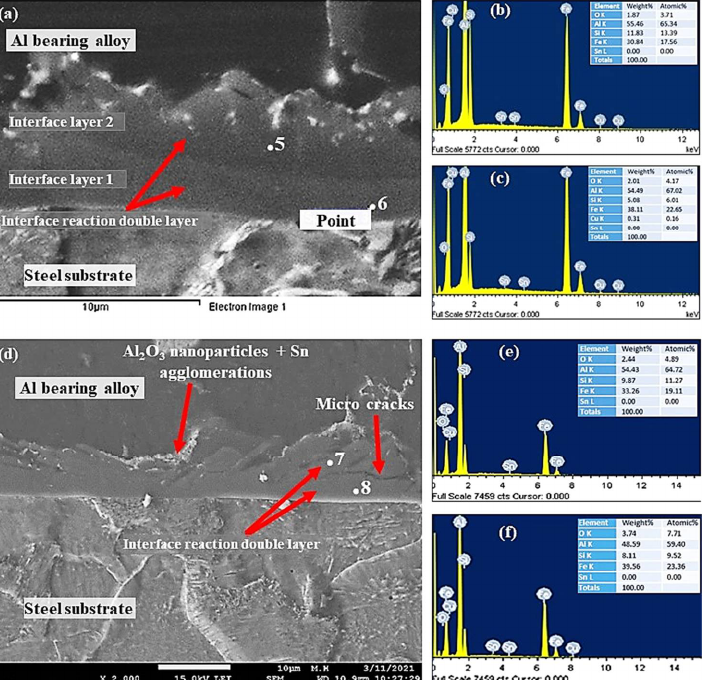
Figure 11. SEM micrographs and EDS from Al-bearing alloy/steel bimetallic composites: ( a ) SEM for bimetal with Sn + 0.50% Al 2 O 3 nanoparticles interlayer (specimen 3); ( b , c ) EDS analysis of points 5 and 6 in ( a ), respectively; ( d ) SEM for bimetal with Sn + 1.00% Al 2 O 3 nanoparticles interlayer (specimen 4); ( e , f ) EDS analysis of points 7 and 8 in ( d ), respectively.